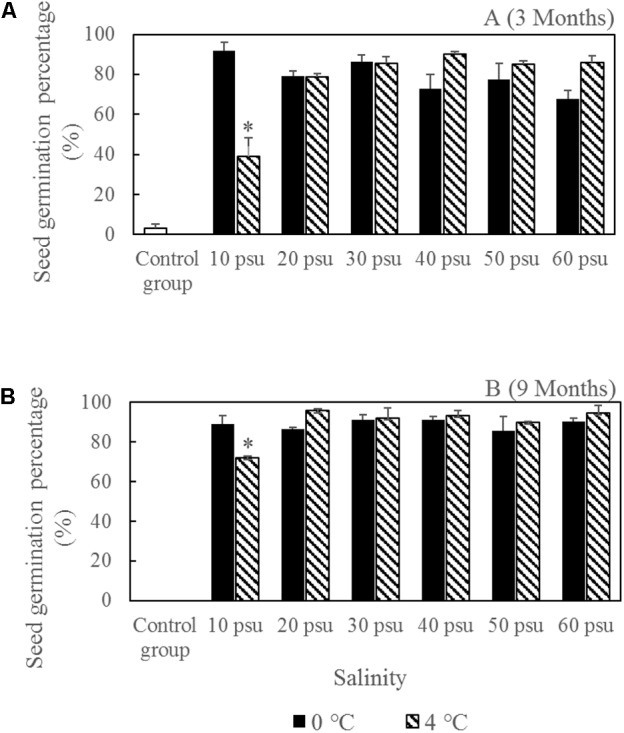
Ruppia sinensis seed vigor after storage for 3 months (A) and 9 months (B) under different salinities and temperatures. ∗Significant difference under the same salinity treatment at two different temperatures. The control group was kept at a salinity of 10 psu and room temperature (10–25°C).